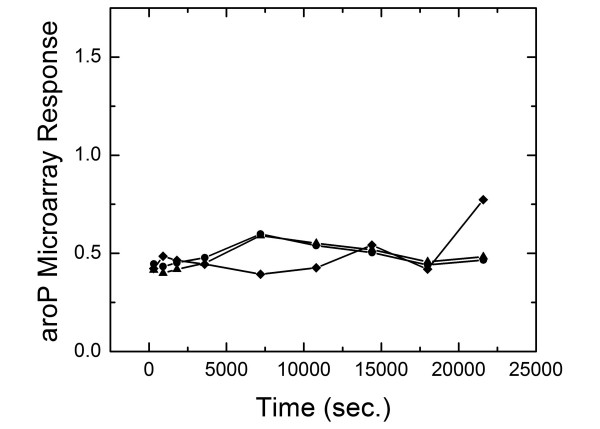
The predicted microarray response of aroP shows no significant improvement as we add the suggested CRP interaction. Diamonds indicate the experimental microarray response; Circles indicate the predicted microarray response before adding the suggested interactions; Triangles indicate the predicted microarray response after adding the suggested interactions.